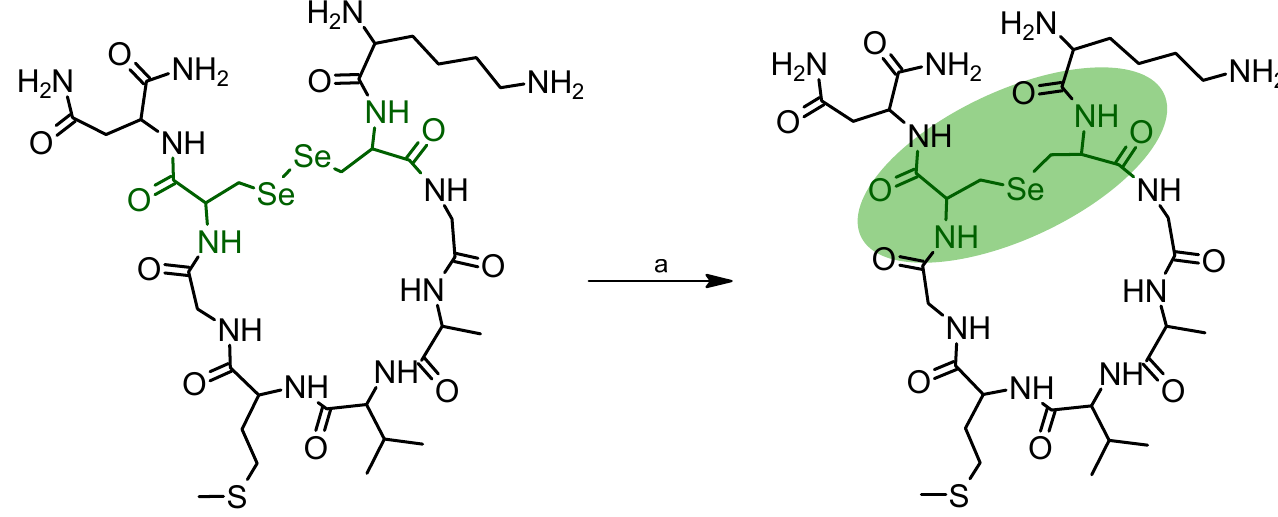
Scheme 7. Photochemical conversion of nisin-diselenide analog (C-ring fragment) to selenolanthion- ine linkage containing analog (green higlighted) (condition (a): MeOH, hv 254